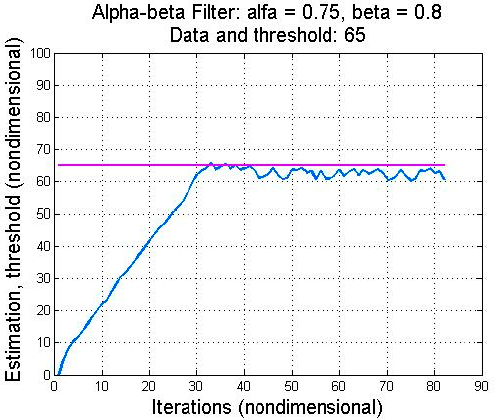
Figure 8. The α – β filter’s estimation of the filter exceeds the threshold, at iteration 33.